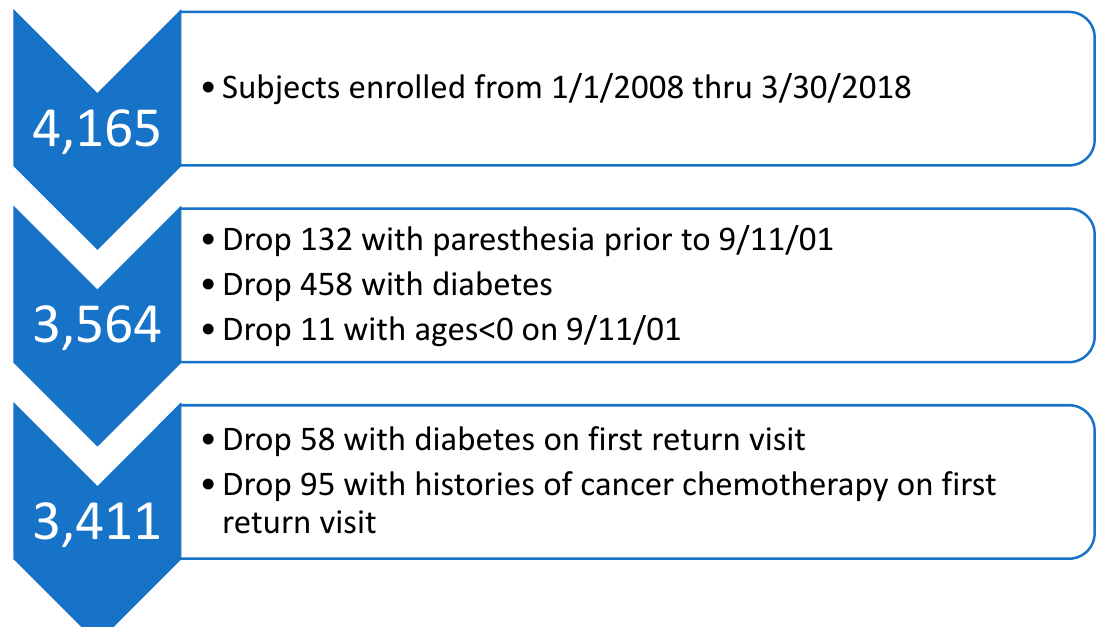
Figure 1. Flowchart of patients included in analyses of time to onset of paresthesia among patients of the Bellevue Hospital WTC (World Trade Center) EHC (Environmental Health Center). Table 1. Baseline characteristics associated with returning percentage for a return visit ( n =